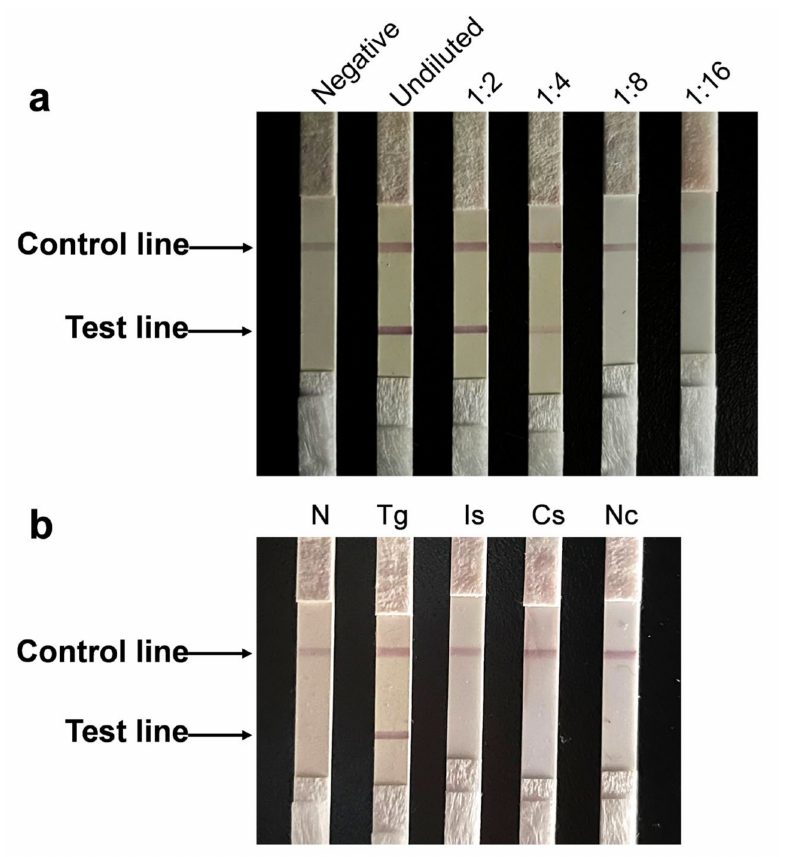
Figure 4. Sensitivity and specificity of the ICT strip. ( a ) Sensitivity of the developed ICT. From left to right: standard T. gondii -negative porcine serum, standard undiluted T. gondii -positive porcine serum; 1:2, 1:4, 1:8 and 1:16 dilution, respectively. ( b ) Specificity of the developed ICT using sera of pigs infected with different pathogens as specified. From left to right: negative control, T. gondii (Tg), I. suis (Is), C. suis (Cs) and N. caninum